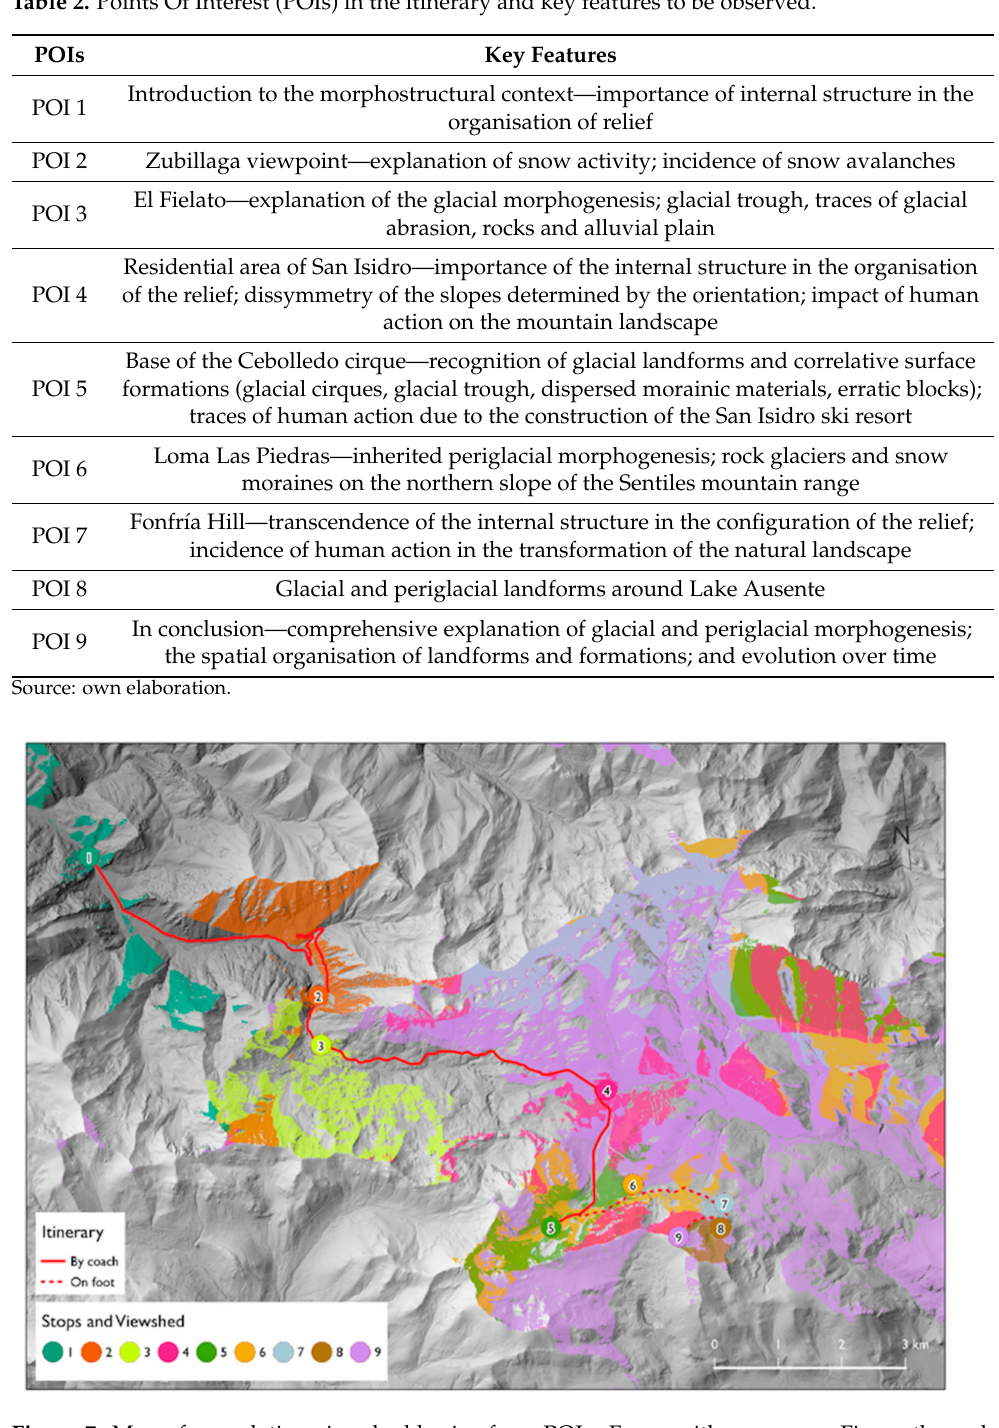
Figure 7. Map of cumulative viewshed basins from POIs. Focus with camera on Figure through Onirix site or use the link